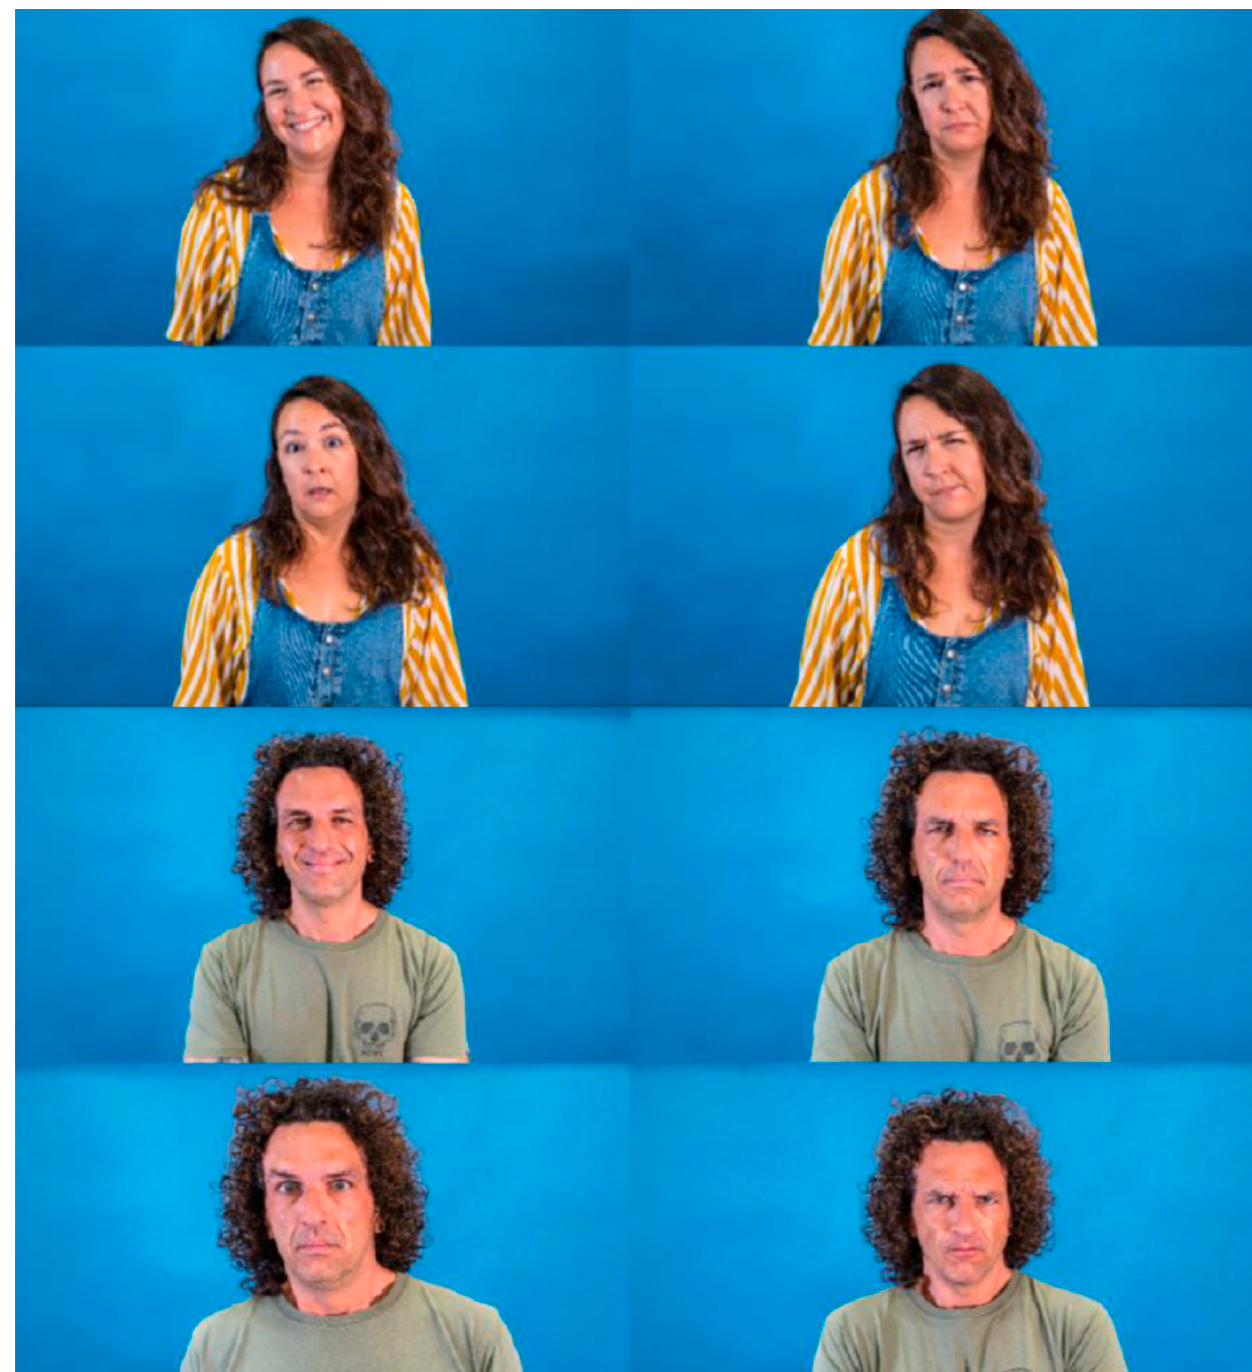
Figure 1. Photographs of the four emotions by an actress and an actor without personal protection equipment (from left to right: happy; sad; fear/surprise; and disgust/anger). *Both actors have agreed to display their images for this research.